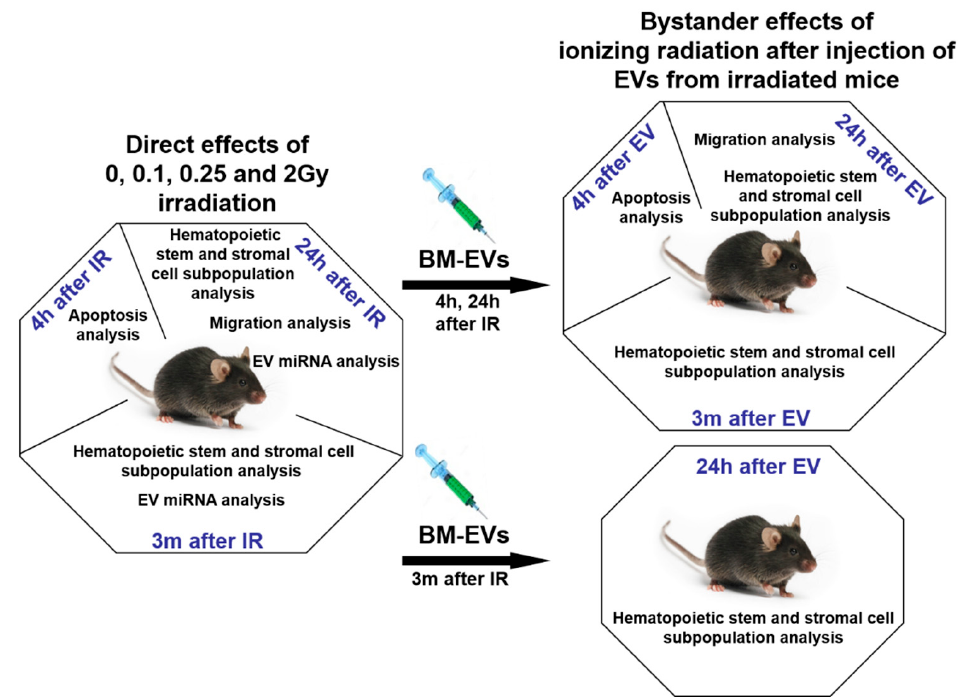
Figure 3. Schematic Presentation of the Workflow of the Study . C57Bl/6 mice were total-body irradiated with different doses (0Gy, 0.1Gy, 0.25Gy and 2Gy) of ionizing radiation. Mice were humanely killed 4 h, 24 h or 3 months later and the bone marrow and spleen were collected. Bone marrow-derived extracellular vesicles were isolated from the bone marrow supernatant of age-matched control and irradiated mice. Bystander effects were monitored in non-irradiated, healthy mice after injecting them with bone marrow-derived extracellular vesicles. Bystander mice were humanely killed 4 h, 24 h or 3 months after extracellular vesicle injection and the same organs were harvested as from the directly irradiated animals. Apoptosis in the bone marrow stem and progenitor cells was measured by TUNEL assay. Bone marrow hematopoietic stem, progenitor and stromal cell subpopulations were characterized phenotypically by flow cytometry. MiRNA expression of BM-EVs was investigated by qRT-PCR.